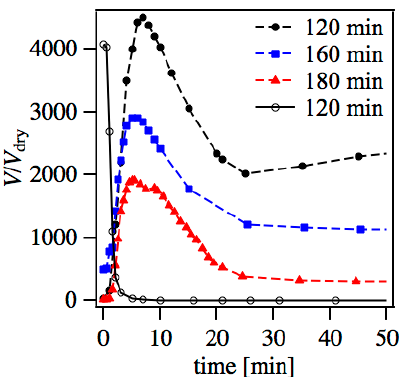
Figure 12. The degree of swelling V / V dry of the carboxylated SR gels as a function of time when solvent was exchanged from 0.1 M NaCl aqueous solution to water (dashed line) and from water to 0.1 M NaCl aqueous solution (solid line). Cross-linking times are 120 min (circle), 160 min (square), and 180 min (triangle), respectively.